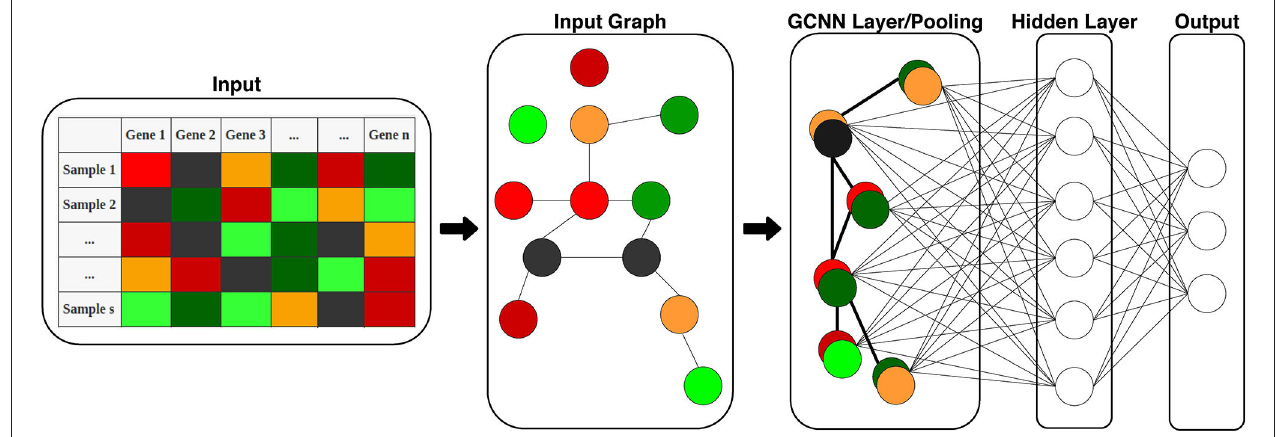
FIGURE 2 | Structure of the proposed GCNN model. The model includes two parts: graph convolution and a fully connected output layer for classification. Input is 1D gene expression levels of TCGA samples and the adjacency matrix of genes (input graph). The graph is then pooled into a single GCNN layer to be fed into the hidden and output